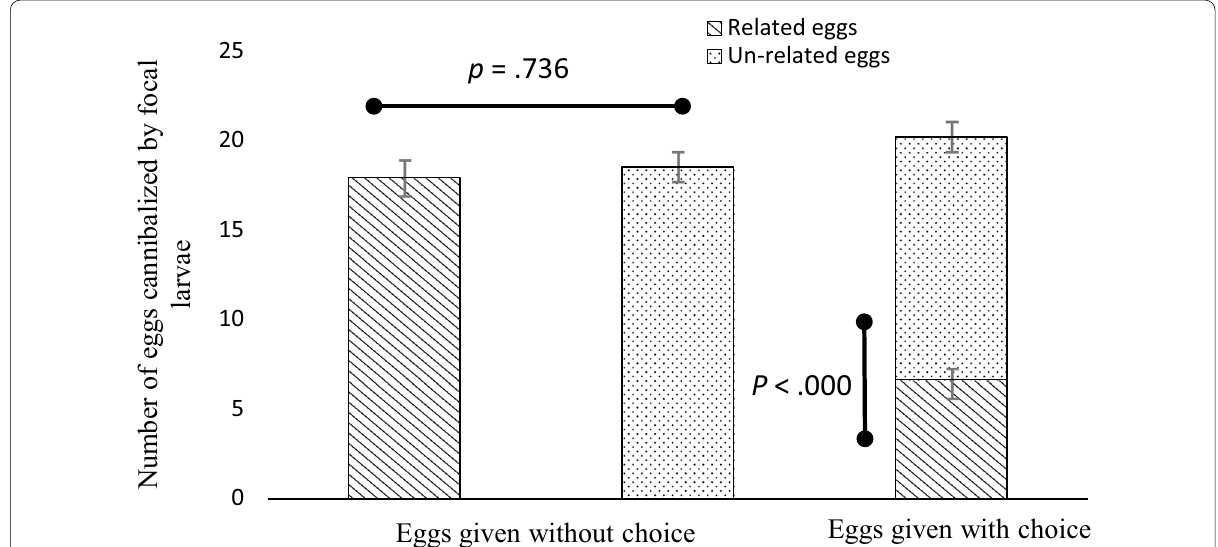
Fig. 5 Number of related or unrelated eggs (means Horizontal lines with circular ends indicate their comparisons with or without